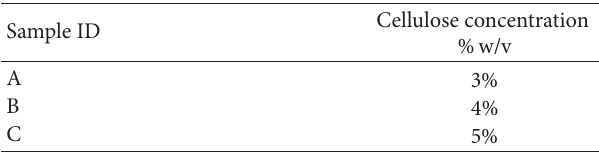
Table 1: Hydrogel formulations tested, differing for cellulose con- centration.